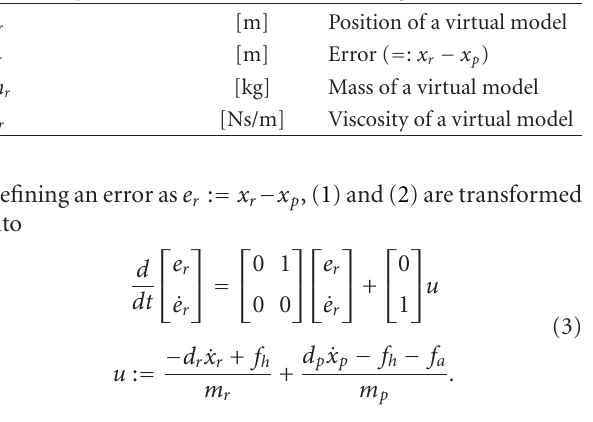
Table 2: Parameters and variables for virtual model control.